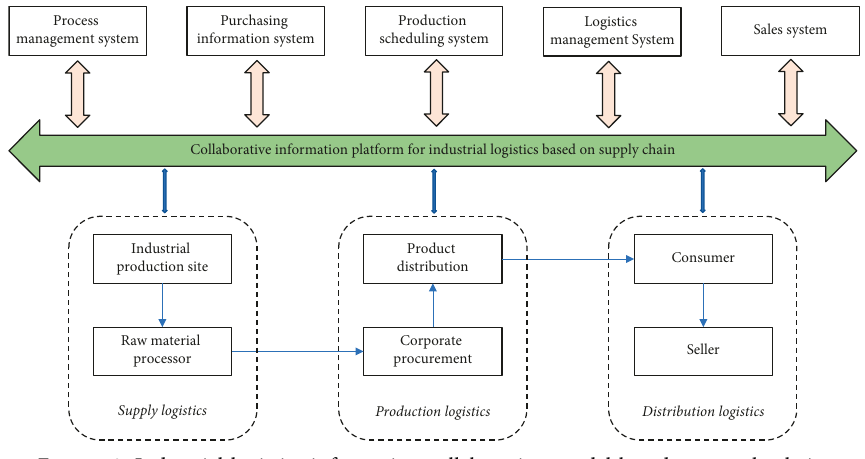
Figure 8: Industrial logistics information collaboration model based on supply